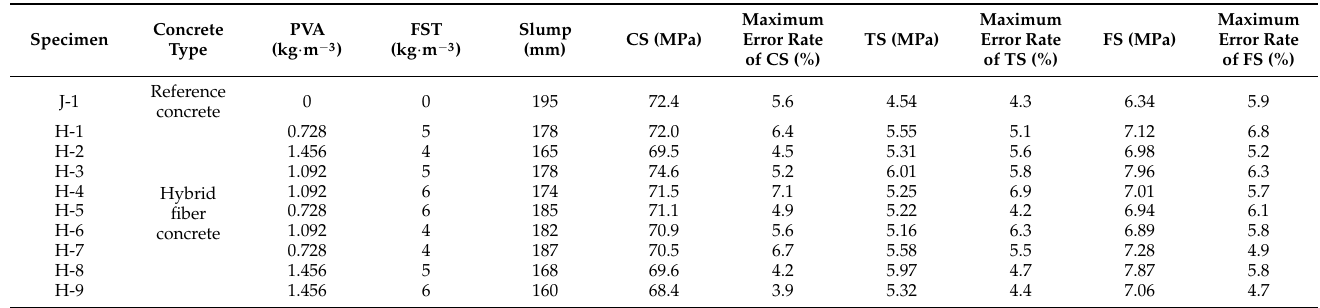
Table 7. Orthogonal test results.